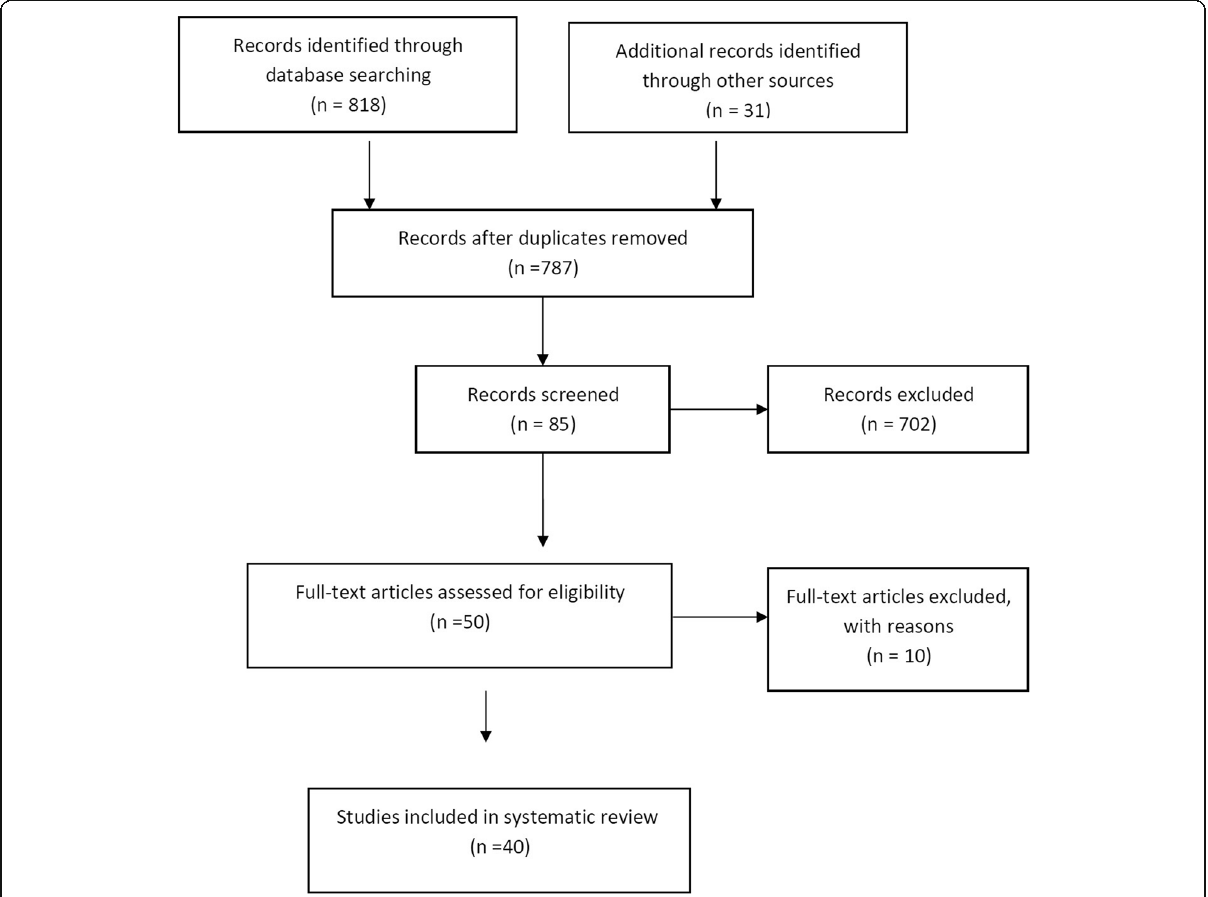
Fig 1. Flow chart illustrating the number of investigations and studies included in the